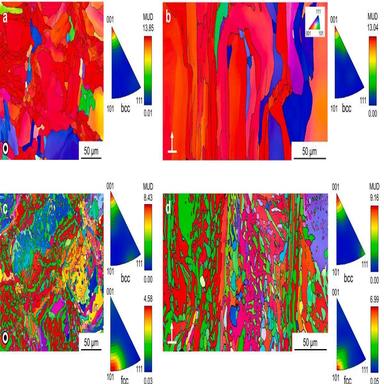
IPF and Z-IPF maps of LPBF DSS 2205 taken from (a) AB build plane (b) AB build direction (c) HT build plane and (d) HT build direction.